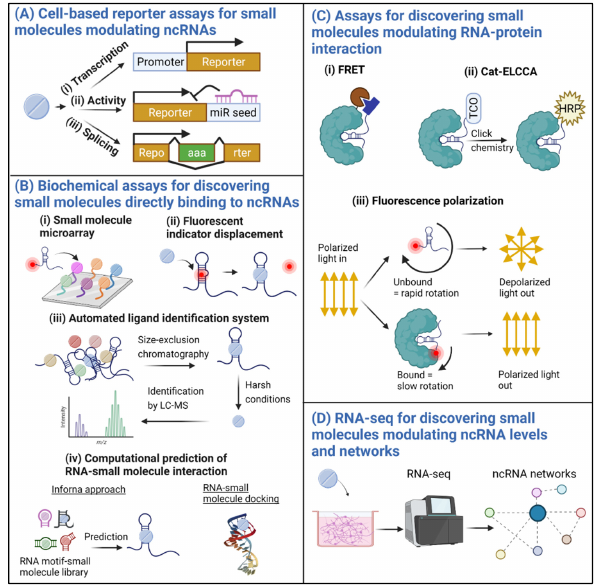
Figure 1. Methods for discovering small molecules modulating the expression level and activity of ncRNAs. ( A ) In the cell-based reporter assays, a fluorescent or luminescent reporter is used to measure ncRNA-expression level or activity: ( i ) if the reporter is under the control of a ncRNA promoter region, small molecules that modulate the reporter may transcriptionally modulate the ncRNA; ( ii ) if the reporter gene is under the control of a region interacting with an ncRNA, small molecules that modulate the reporter may regulate the expression level or activity of the ncRNA; ( iii ) for variants of an ncRNA produced from alternative splicing, small molecules that modulate the in-frame expression of the reporter gene may regulate alternative splicing to favor the production of a specific variant. ( B ) Various biochemical assays can be used to discover small molecules that bind directly to ncRNAs to modulate their configuration and function: ( i ) in the small molecule microarray assay, small molecules are immobilized on glass slides and then incubated with fluorophore-bound ncRNAs. After unbound ncRNAs are washed away, fluorescence signals may indicate binding between a small molecule and the ncRNA; ( ii ) in the fluorescent indicator displacement (FID) assay, the ncRNA is first reversibly attached to a fluorescent indicator. Small molecules that bind to and displace the indicator result in a loss of fluorescent signal; ( iii ) in the automated ligand identification system (ALIS), the ncRNA of interest is first incubated with various small molecules. RNA-small molecule complexes are then separated from unbound RNAs and small molecules by size-exclusion chromatography, followed by treatment under harsh conditions to release the small molecules from the complexes. The small molecules are then identified by liquid chromatography-mass spectrometry (LC-MS); ( iv ) computational methods can also screen millions of small molecules to predict those that are more likely to bind to a particular ncRNA. The Inforna platform utilizes known RNA motif– small molecule interactions to predict compounds for specific RNA secondary structures. RNA structures produced by X-ray crystallography or nuclear magnetic resonance (NMR) can also be used to facilitate small molecule—RNA docking. ( C ) Several assays can also be used to discover small molecules that modulate RNA-protein interaction: ( i ) in the fluorescence resonance energy transfer (FRET) assay, the protein can be tagged with a fluorophore, whereas the ncRNA is tagged with either an activator or a quencher; ( ii ) in the catalytic enzyme-linked click chemistry assay (cat-ELCCA), the protein is immobilized, while the RNA is tagged with a handle such as a 5 (cid:48) -trans-cyclooctene (TCO) that can be converted into horseradish peroxidase (HRP) using click chemistry; ( iii ) in the fluorescence polarization assay, small molecules bound to proteins rotate more slowly than unbound molecules, resulting in more highly polarized light emission. Small molecules that modulate the fluorescent, or luminescent, or polarized light intensity in these assays may also modulate ncRNA- protein interaction. ( D ) High throughput ncRNA-seq can be used to directly identify ncRNAs that are differentially expressed in cellular models treated with small molecules. This approach also enables the construction of ncRNA networks altered by a particular small